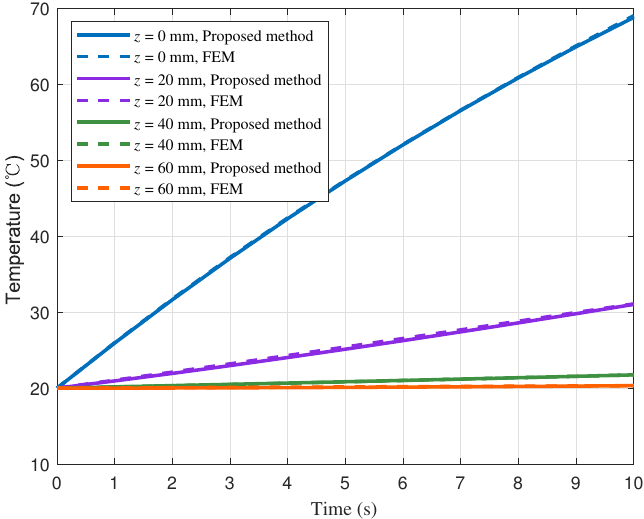
Figure 9. Comparison of the temperature variation results with time at different depths.